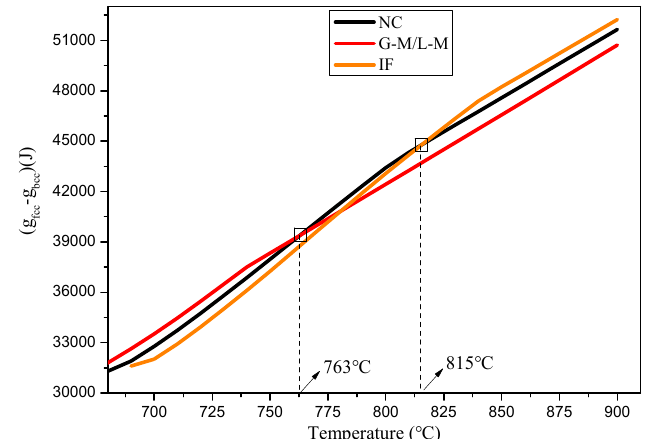
Figure 6. The intrinsic energy difference of fcc phase and bcc phase when bcc phase transformed into fcc phase for the compositions of NC, G-M / L-M and I-F calculated by thermo-calc 3.0 based on TCFE 7.